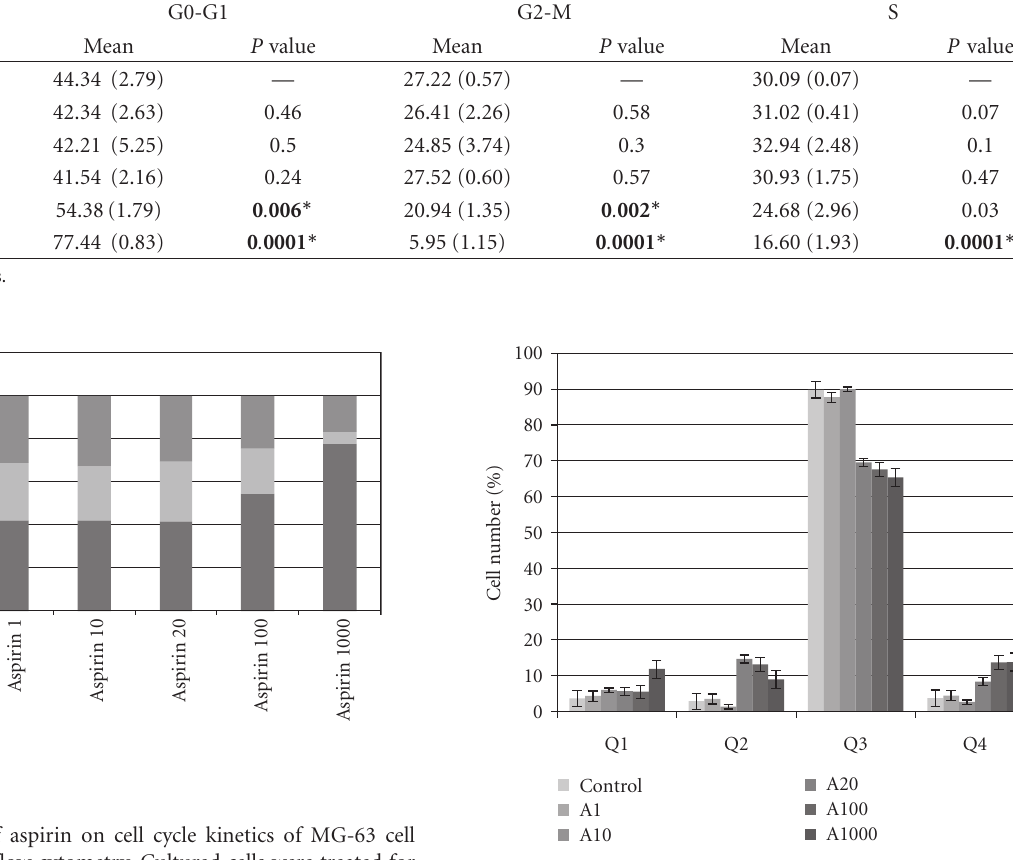
Figure 3: Percentage of Annexin V binding and propidium iodide uptake of MG63 cells after culture for 12h. Q1 (necrosis: Ann V − , PI + ), Q2 (late apoptosis: Ann V + , PI + ), Q3 (viable cells: Ann V − , PI − ), and Q4 (early apoptosis: Ann V + , PI − ). Data are means ± standard deviation of at least three independent